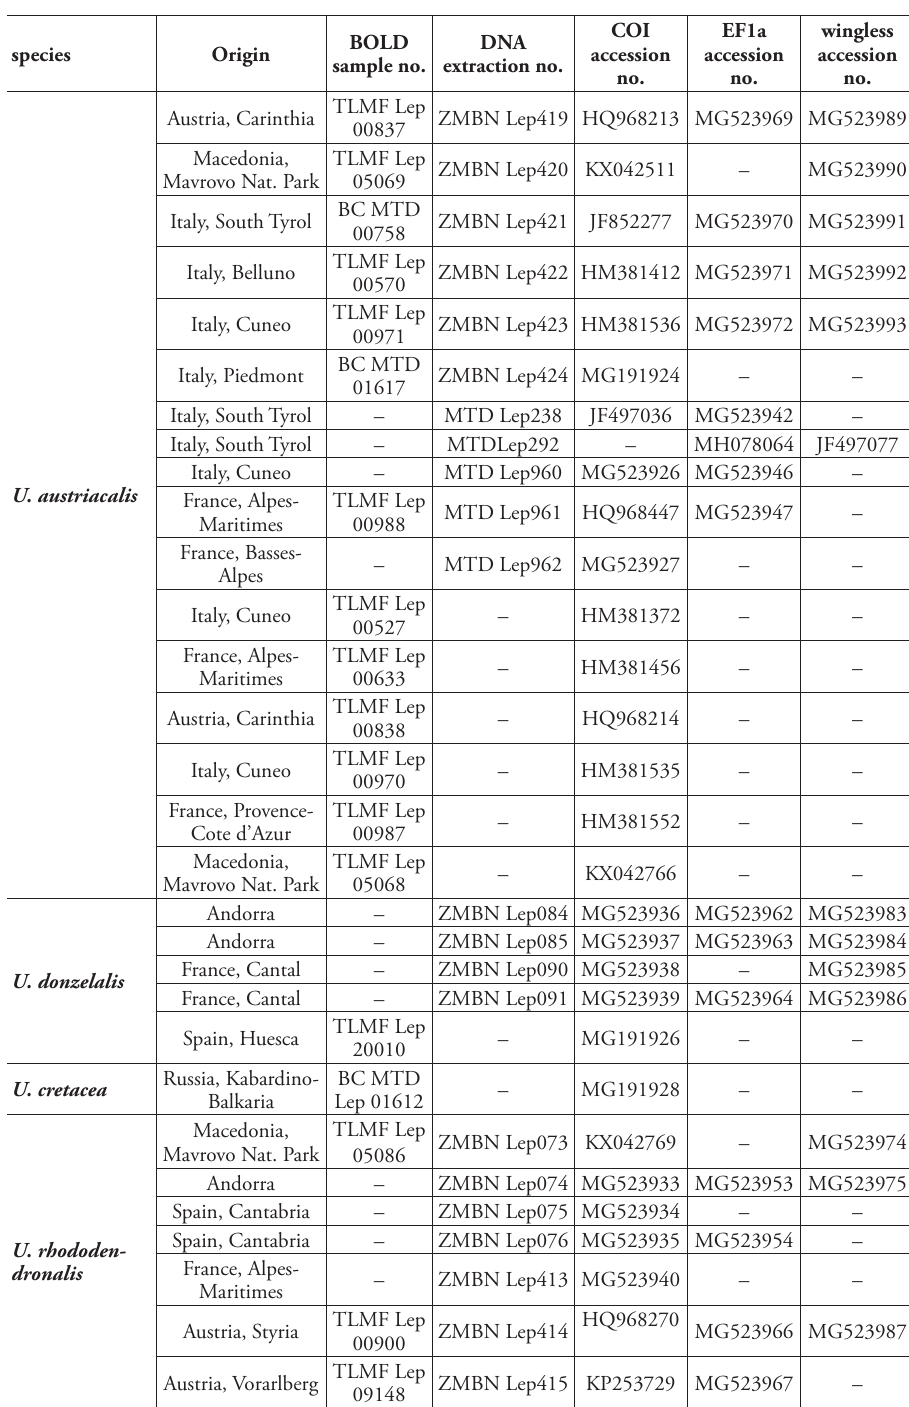
Table 2. Origin and gene sequence data of the genetically investigated Udea material. species Origin